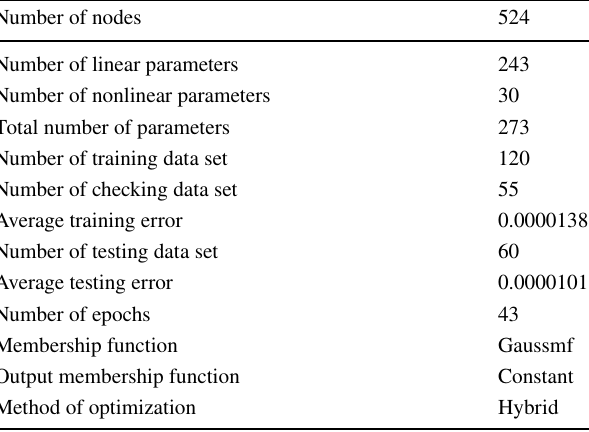
Table 6 ANFIS architecture and training